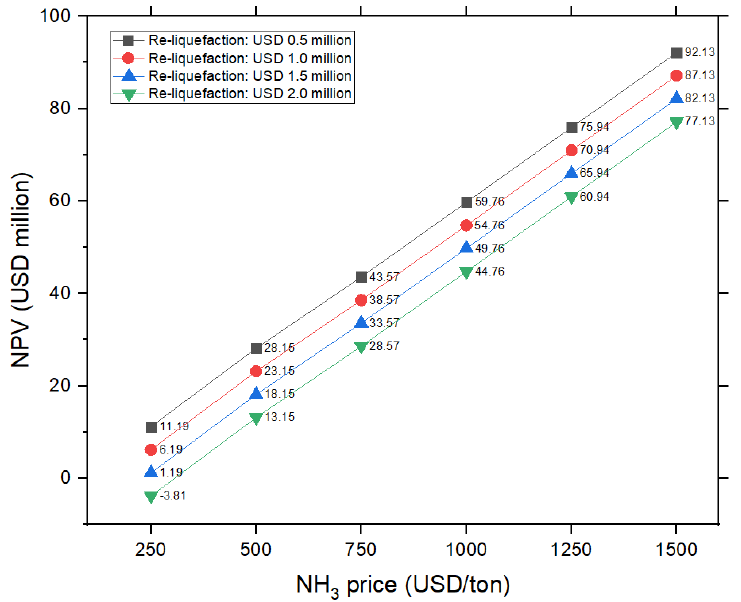
Figure 7. NPV for the NH 3 and re-liquefaction price.